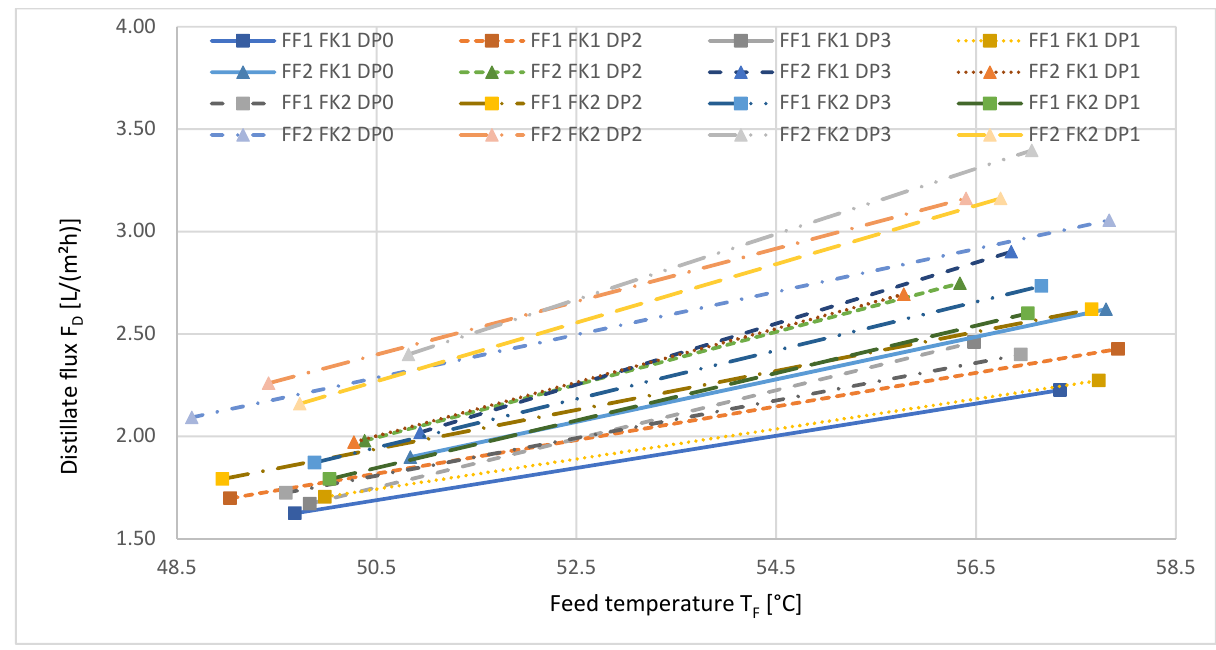
Figure 8. Distillate flux as a function of the feed temperature during VMD. Δ p = const., F F = const., F K = const. during the respective measurement series. The numbers refer to the different reference levels, without pressure (0), low (1), medium (2), and high (3), described in Table 4.